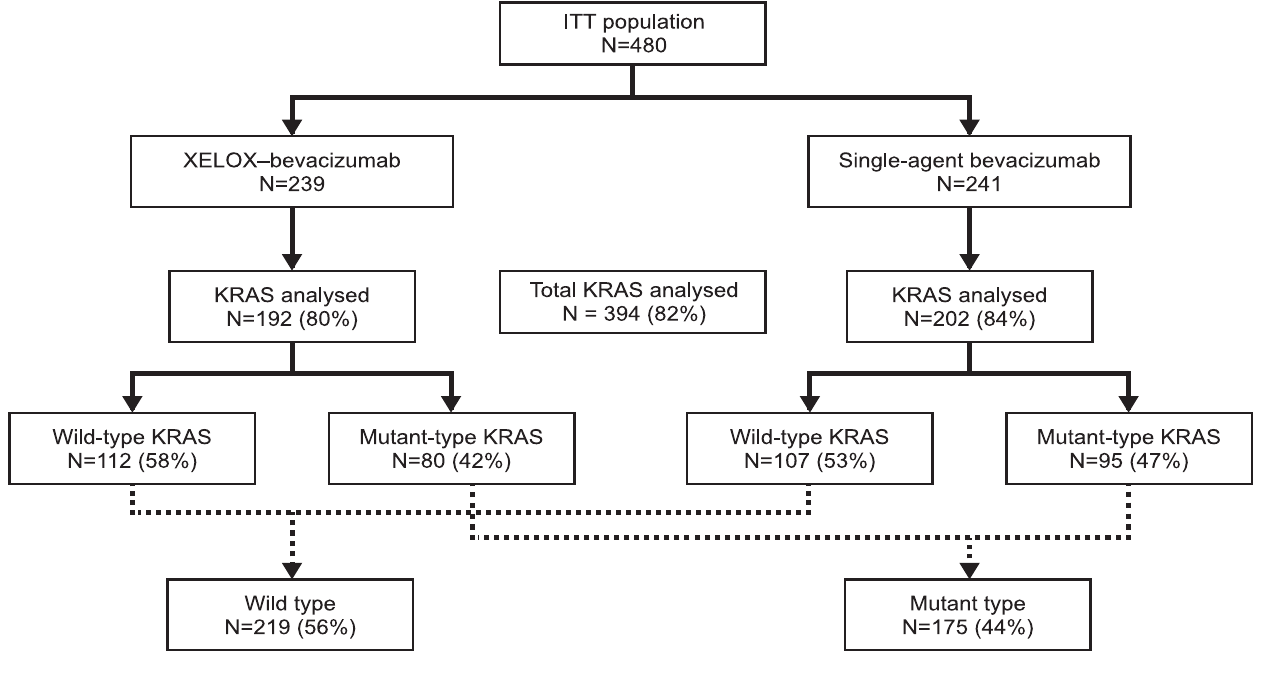
Figure 1. Patient flow.